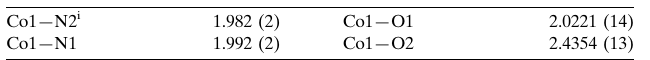
Selected bond lengths (A˚ ).